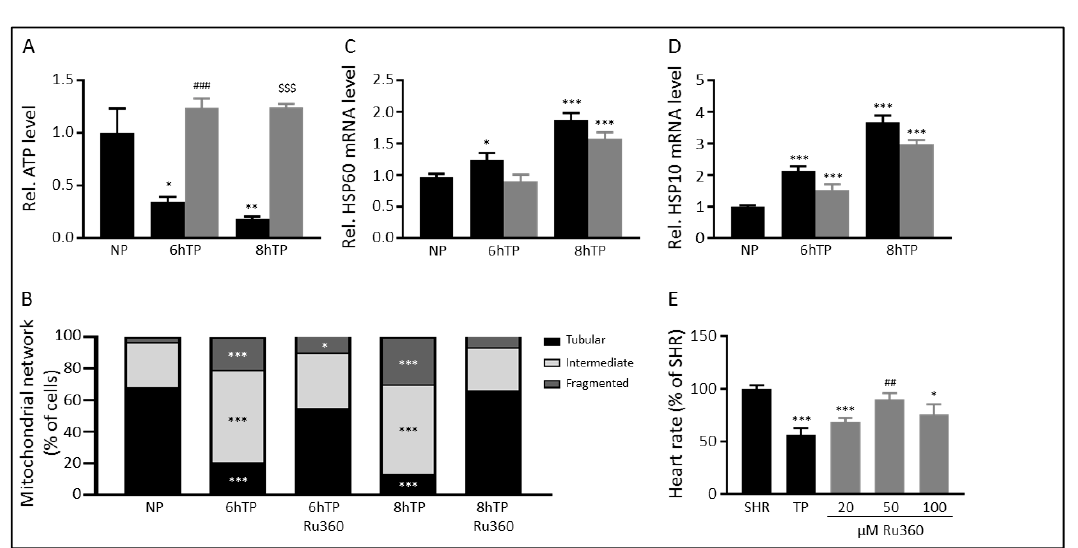
Figure 4. Inhibition of the MCU by Ru360 protects against mitochondrial dysfunction and stress. ( A ) Protection of Ru360 (5 µM) treatment on cellular ATP levels after normal-pacing (NP) or tachypacing (TP). Black bars represent non-treated HL-1 cardiomyocytes, grey bars represent Ru360-treated cardiomyocytes. ( B ) The transition of the mitochondrial network from tubular to fragmented from NP to TP with and without Ru360 treatment. Quantitative real-time PCR of mitochondrial stress markers show no protection of Ru360 on ( C ) HSP60 and ( D ) HSP10 transcription levels in response to NP and TP. Black bars represent non-treated HL-1 cardiomyocytes, grey bars represent Ru360-treated cardiomyocytes. ( E ) Quantified data showing heart wall contraction rates (heart rate) before (SHR, spontaneous heart rate) and after tachypacing (TP and grey bars). Black bars represent non-treated Drosophila , grey bars represent Ru360-treated Drosophila . * p < 0.05, ** p < 0.01, *** p < 0.001 vs. NP or SHR, ## p < 0.01, ### p < 0.001 vs. TP (6 h), $$$ p < 0.001 vs. TP (8 h).